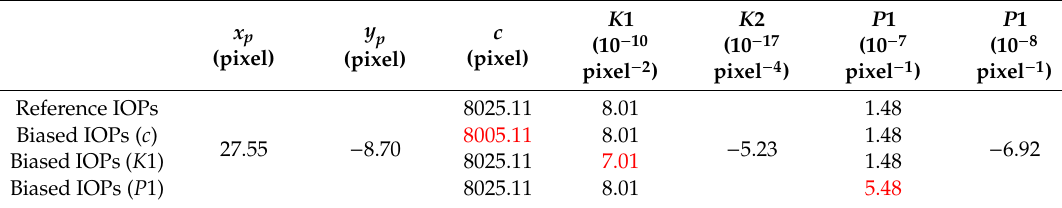
Table 2. Reference and biased IOPs used in the bias impact analysis (biased parameters are colored in